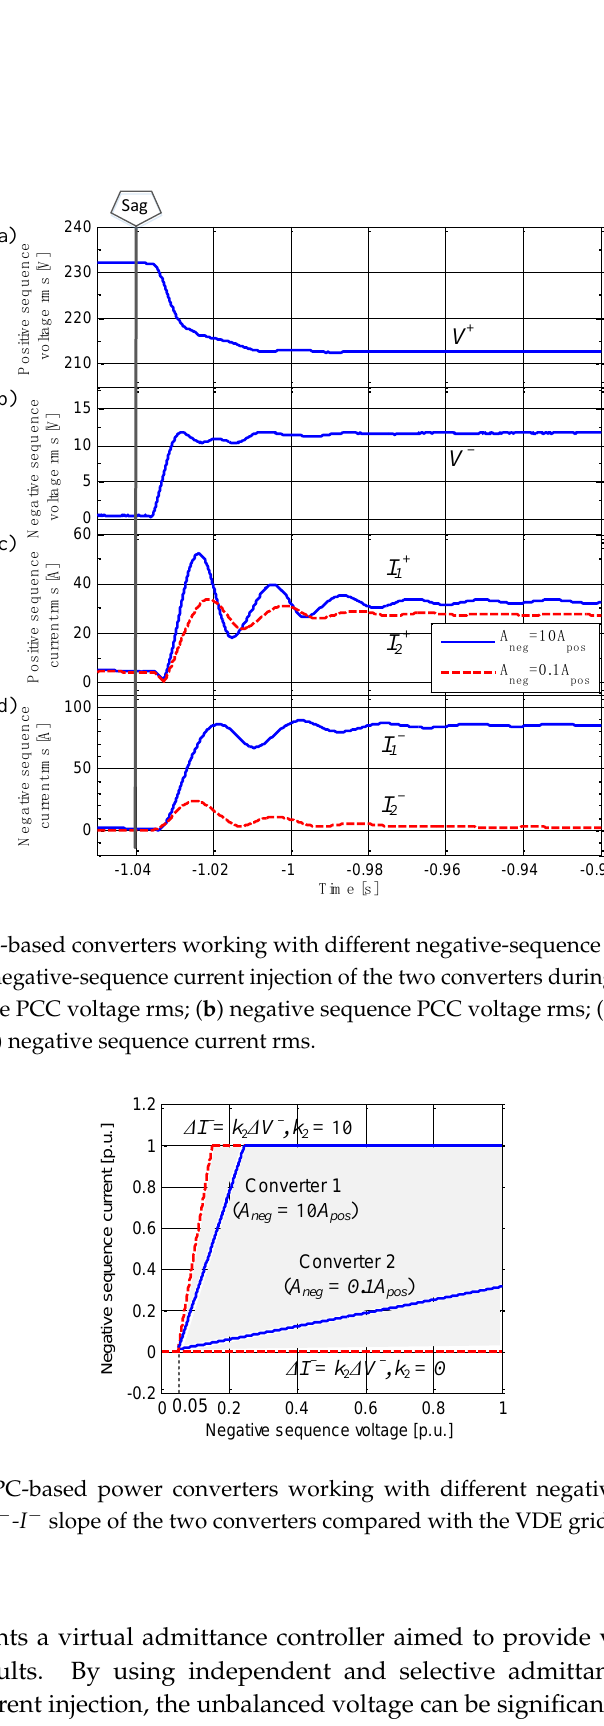
Figure 19. Two SPC-based power converters working with different negative sequence virtual admittances. The V − -I − slope of the two converters compared with the VDE grid codes.